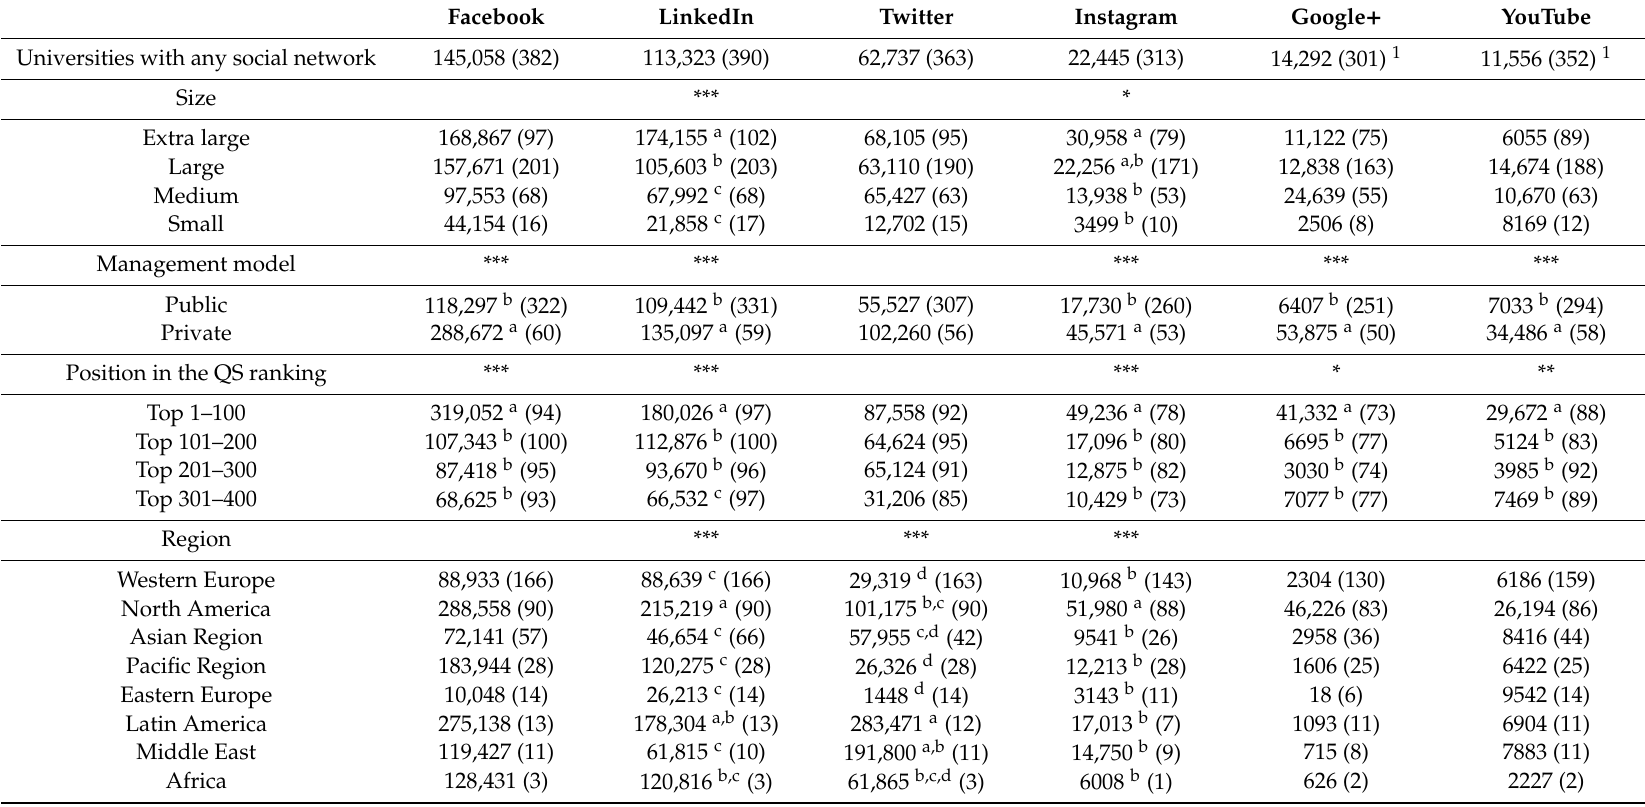
Table 2. Average number of universities’ followers on social networking